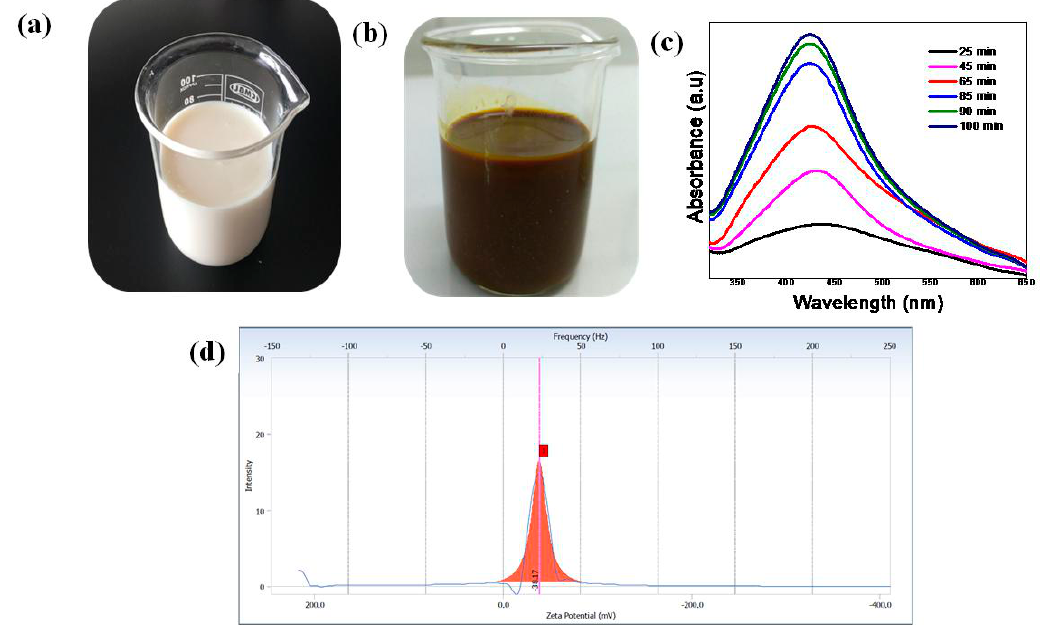
Figure 1. Photographs of ( a ) commercial milk and ( b ) milk protein-stabilized silver nanoparticles (MP-s-AgNPs) solution after 100 min and ( c ) UV-Vis spectra of MP-s-AgNPs recorded at different time interval. ( d ) Zeta potential plot for AgNPs produced using milk, showing the excellent stability of MP-s-AgNPs.